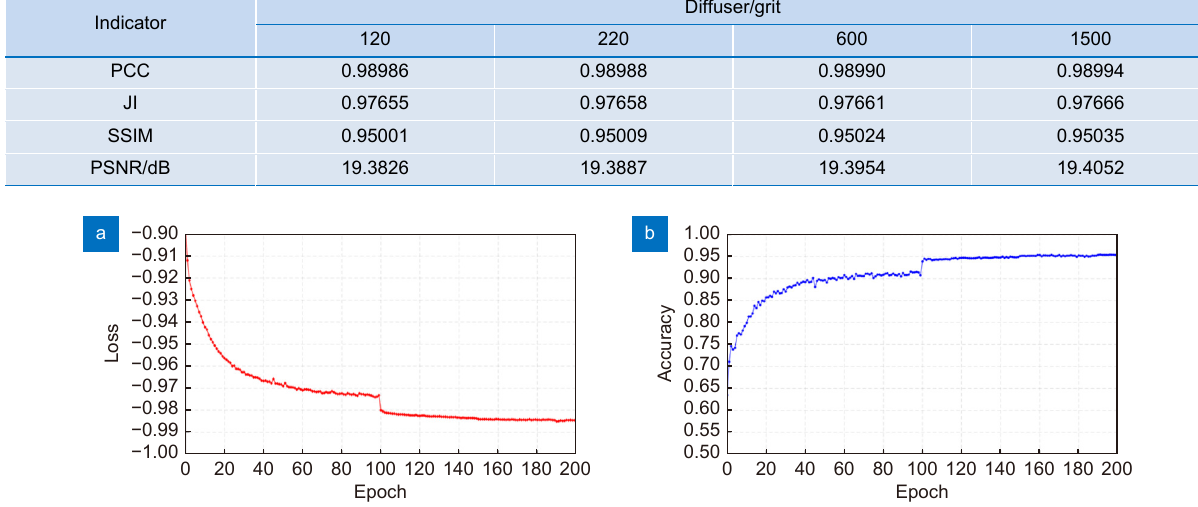
Fig. 7 | Quantitative analysis of the trained SpT UNet using NPCC as the loss function ( a ) and SSIM as the indicator for accuracy ( b ).